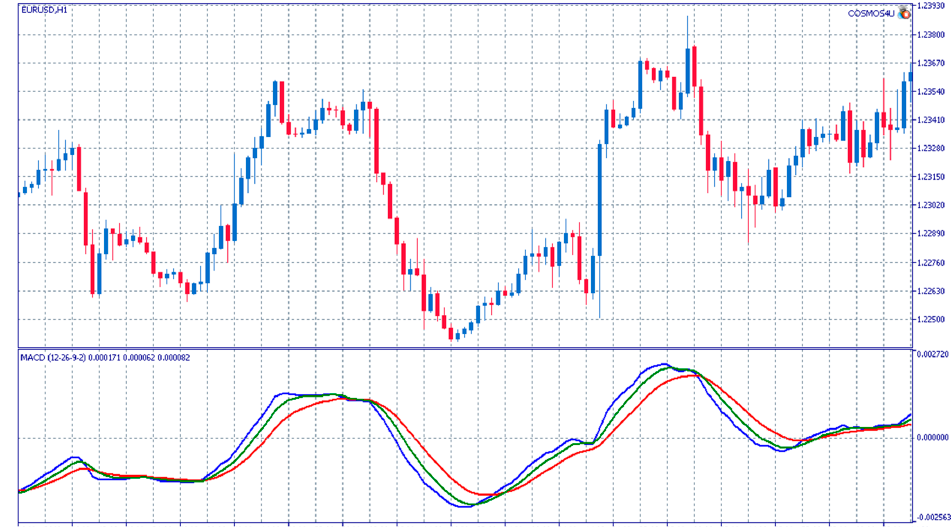
Figure 2. EURUSD chart with an MACD line (blue), a Signal line (red), and a Take Profit Signal line (green) below.